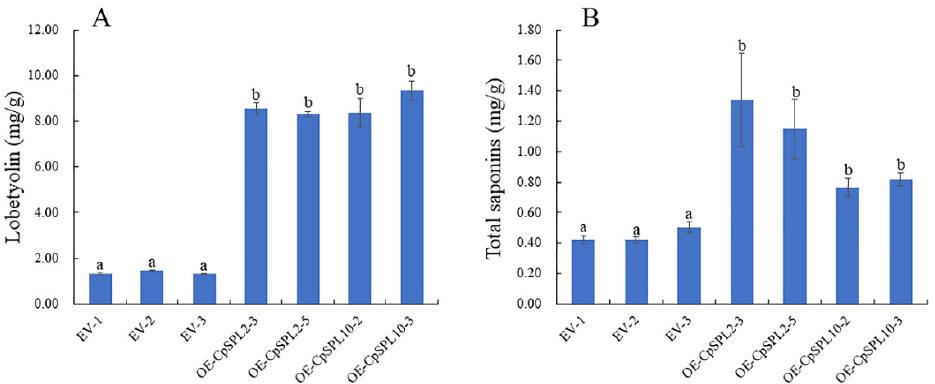
Figure 7. Concentration of lobetyolin ( A ) and total saponins ( B ) contents in Codonopsis pilosula transgenic hairy roots. One-way ANOVA (followed by Tukey’s comparisons) tested for significant differences among means (indicated by different letters at p < 0.05).